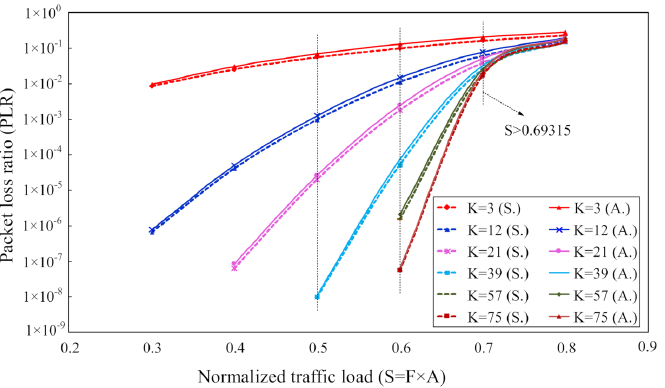
Figure 5. Packet loss ratio versus normalized incoming traffic load per